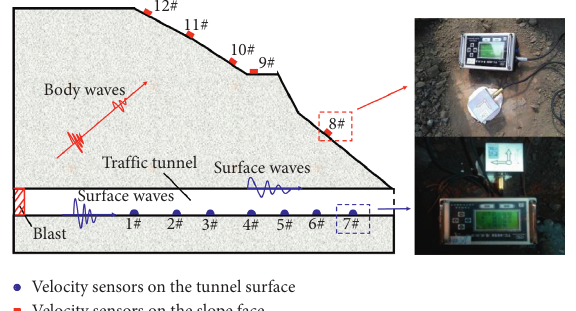
Figure 4: The arrangement of blasting vibration monitoring